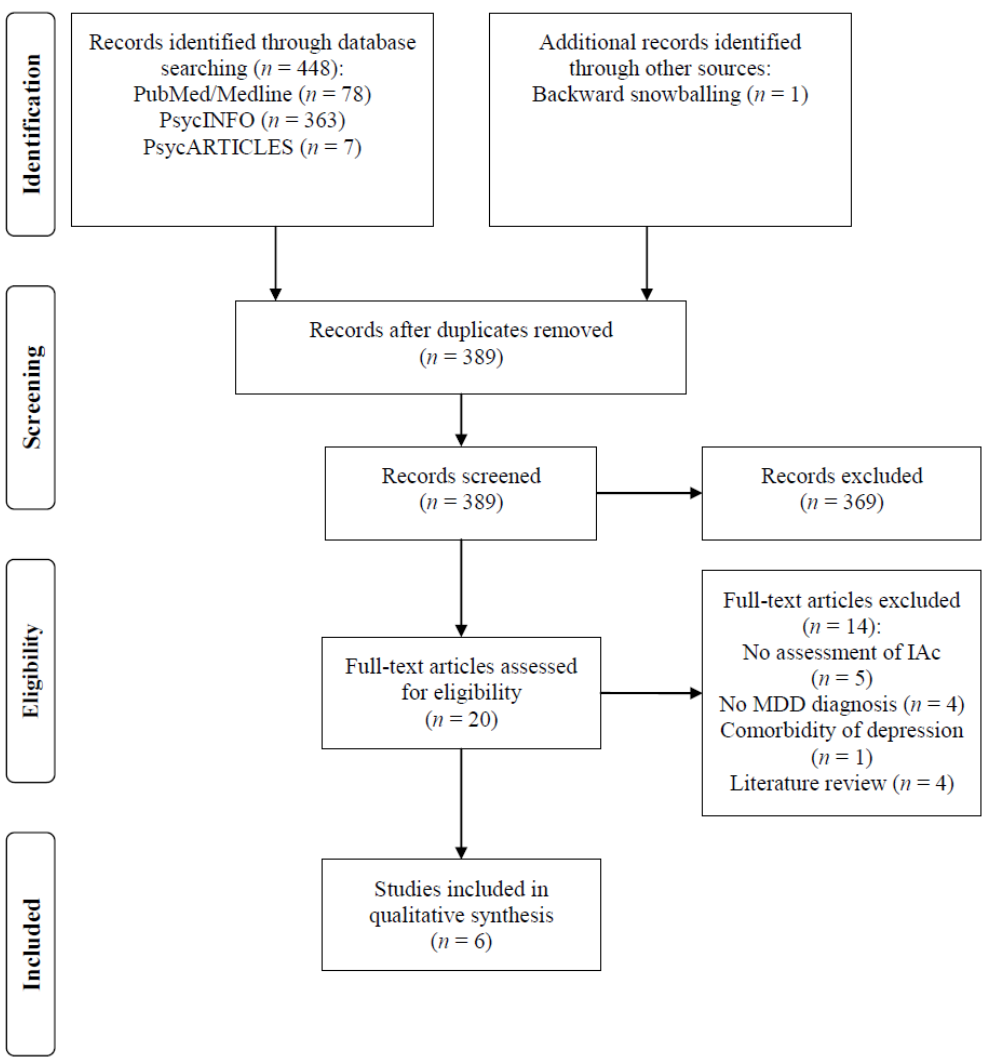
Figure 1. PRISMA flowchart of study selection